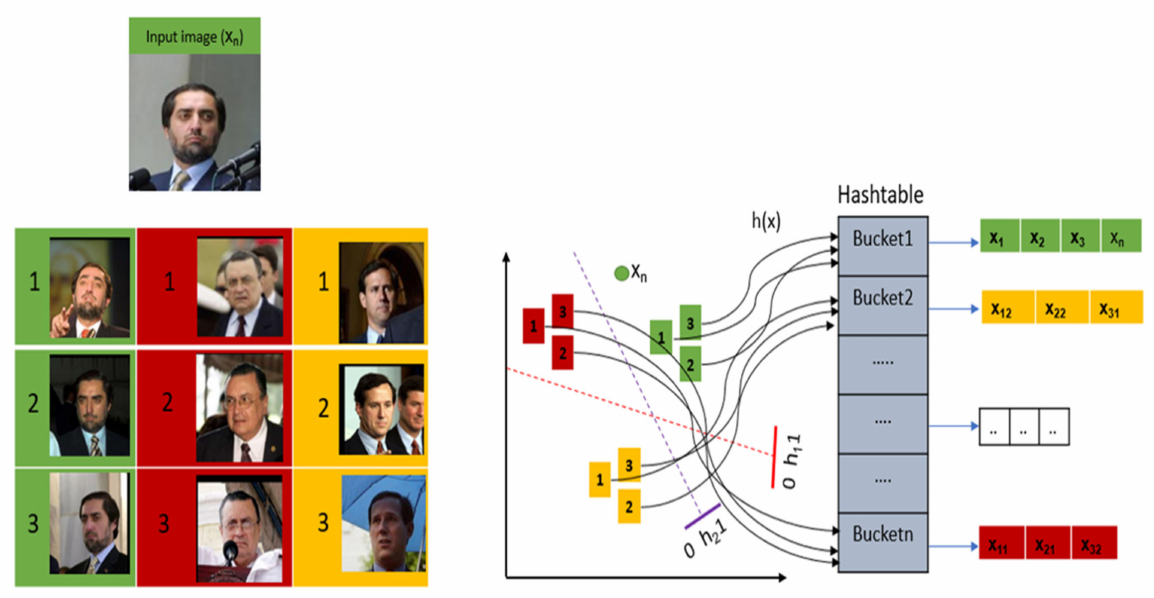
Figure 2. Creating an image data index using LSH; each bucket represents a subject in this context.